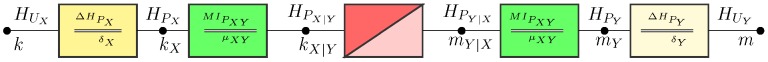
(Color online) Entropy (above) and perplexity (below) decomposition chains for a joint distribution.Left, perplexity reduction in the input (learning) chain; right, perplexity increase in the output chain, related to classifier specialization. The colors refer to those of Fig. 5.(B). The ordering of the boxes is a convention to reveal the prior and posterior natures of the perplexities of class distributions.